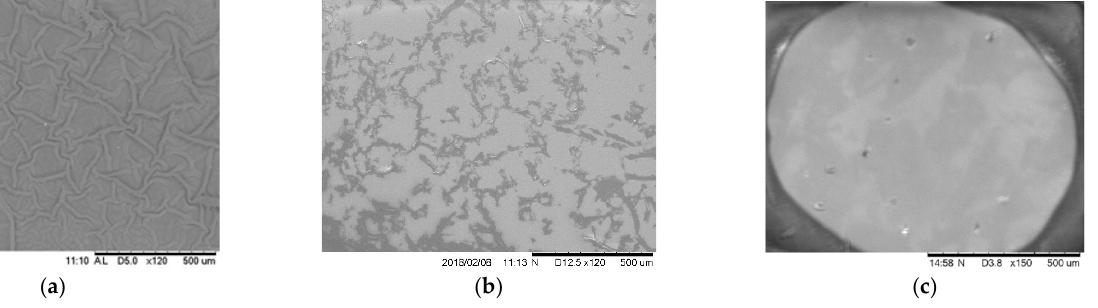
Figure 5. Surface topographical images of the ( a ) PEGDA-PCL, ( b ) SA-PCL, and ( c ) CG1-PCL specimen collected using a scanning electron microscope. The scale bar for all images is 500 µm.